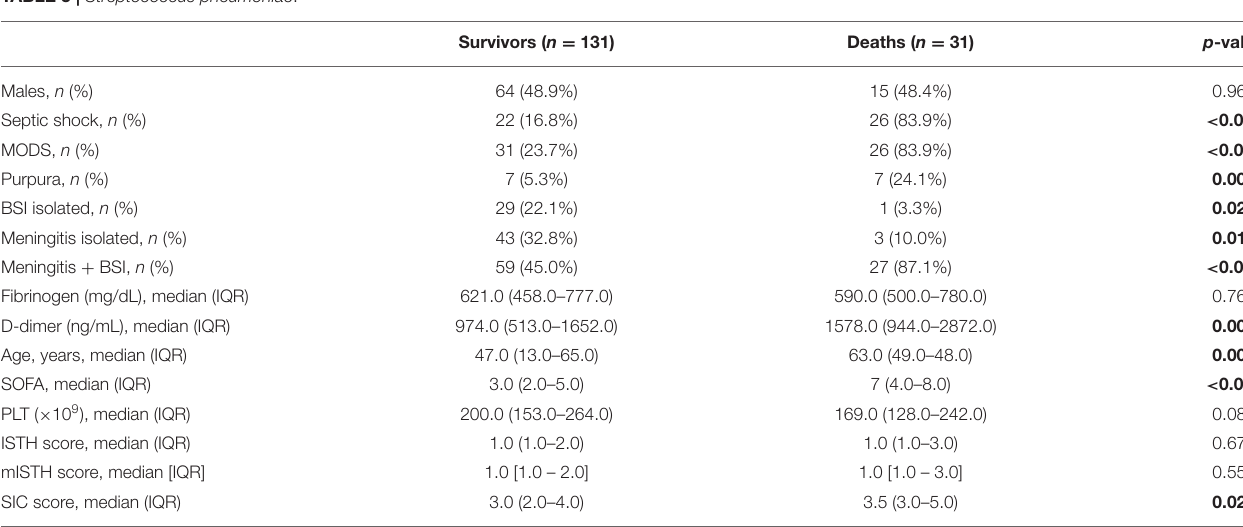
TABLE 3 | Streptococcus pneumoniae